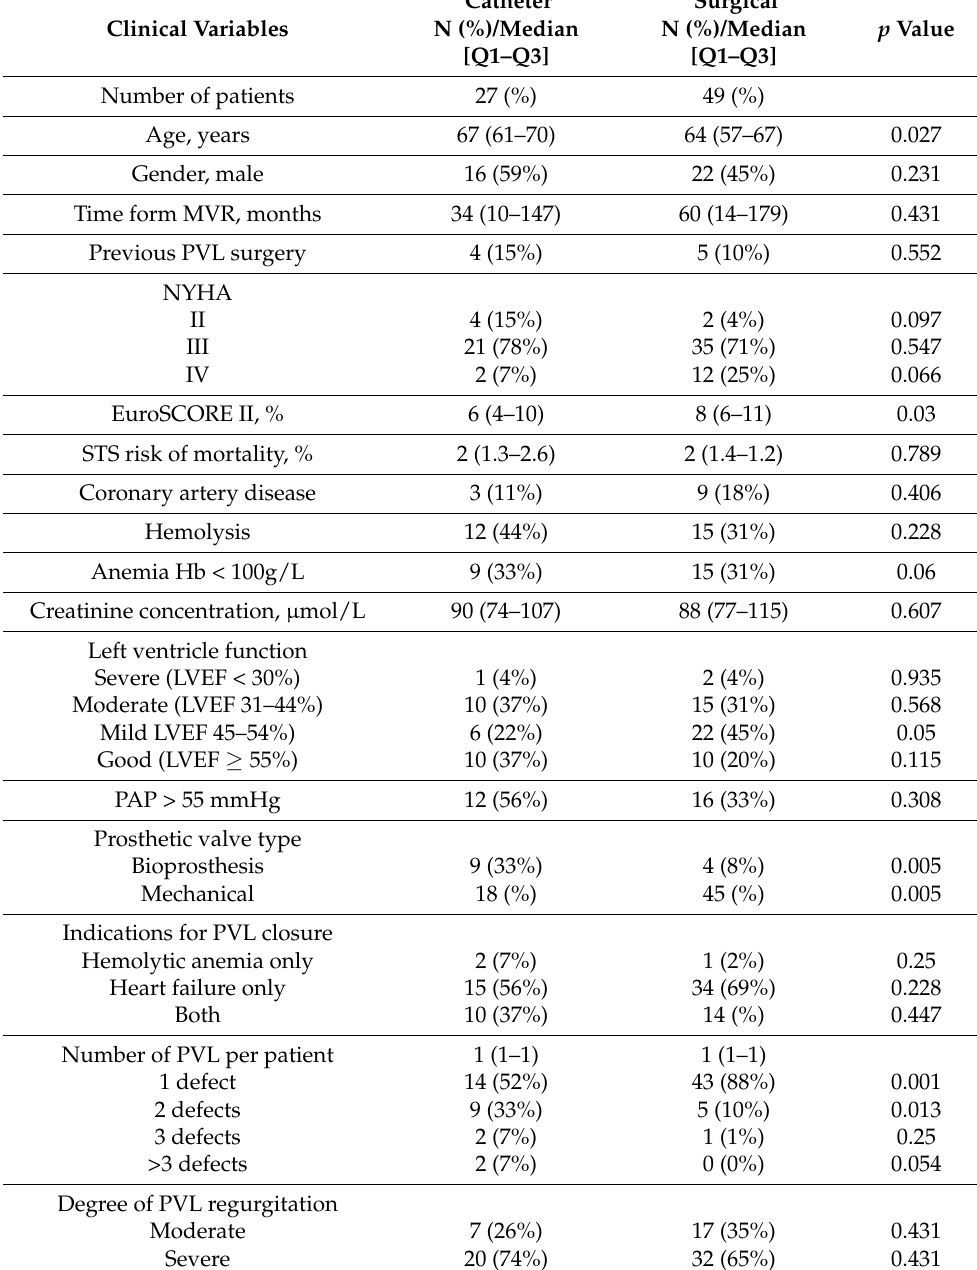
Table 1. Preoperative patient